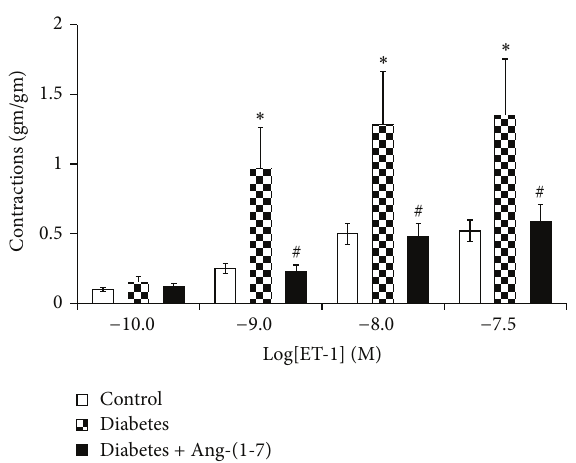
Figure 1: Endothelin-1-induced vasoconstriction in the corpus cavernosum segments from nondiabetic (control), diabetic, and diabetic rats treated with Ang-(1-7) (Mean ± SEM, 𝑛 = 6 –8). Asterisk ( ∗ ) indicates significantly different mean values as compared to control, and hash (#) indicates significantly different mean values as compared to diabetes. 𝑃 < 0.05 . Tissues isolated from 6-week diabetic rats treated with Ang-(1-7) for the last 3 weeks of the study.